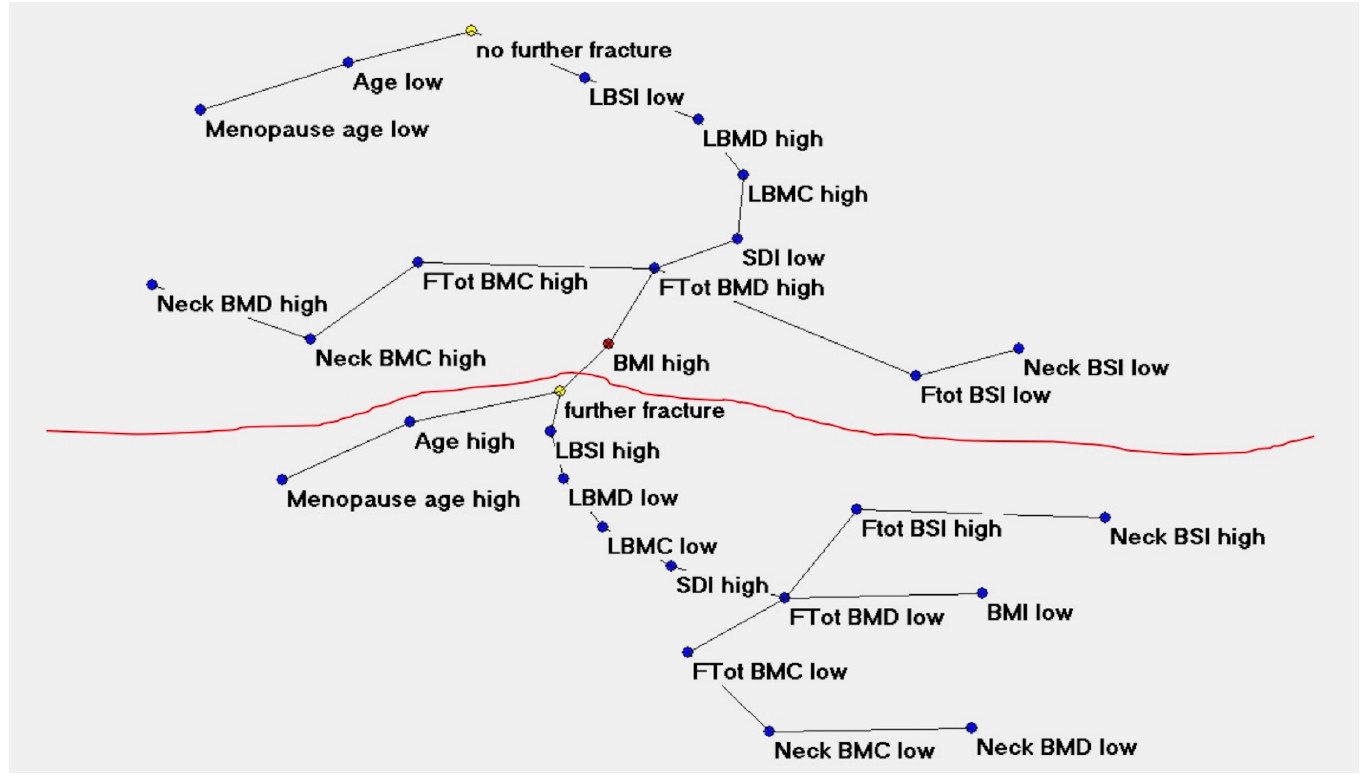
Fig 3. Semantic connectivity map of the studied